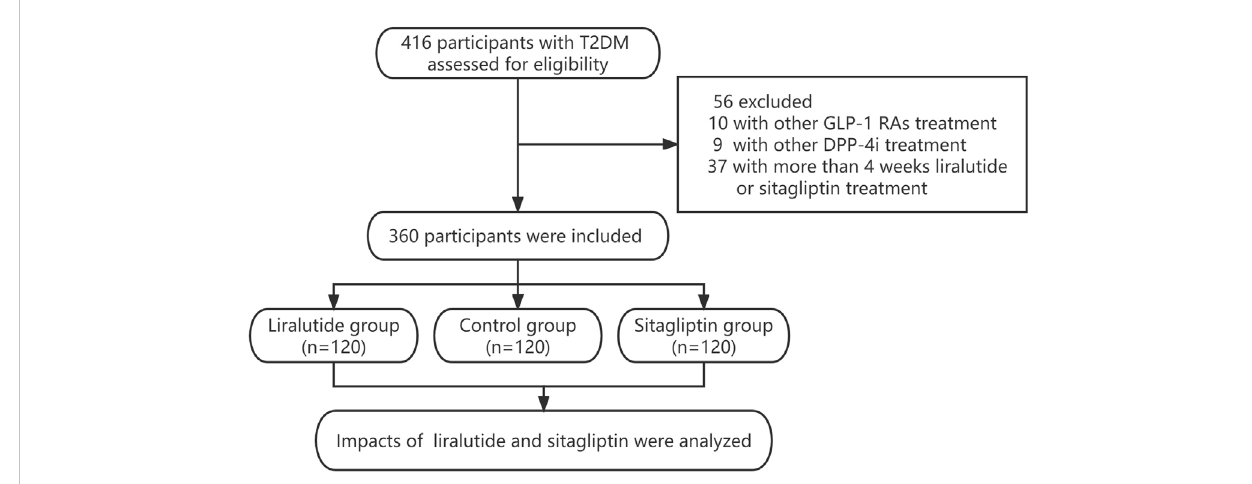
FIGURE 1 Flowchart describing the selection process of the study population in this